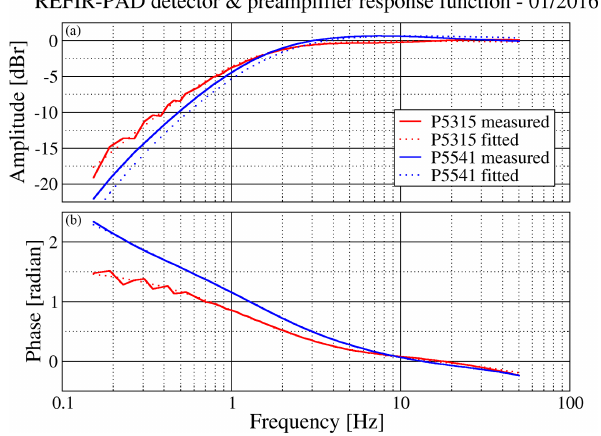
Figure 6. REFIR-PAD detector preamplifier response as measured in normal operating conditions, along with a fit of the theoretical model used to measure the detectors’ characteristic low- and high- pass